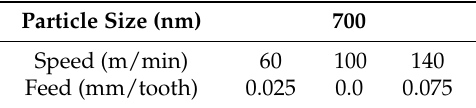
Table 1. Parameter variations in milling metal matrix composites (MMCs) reinforced with SiC particles.